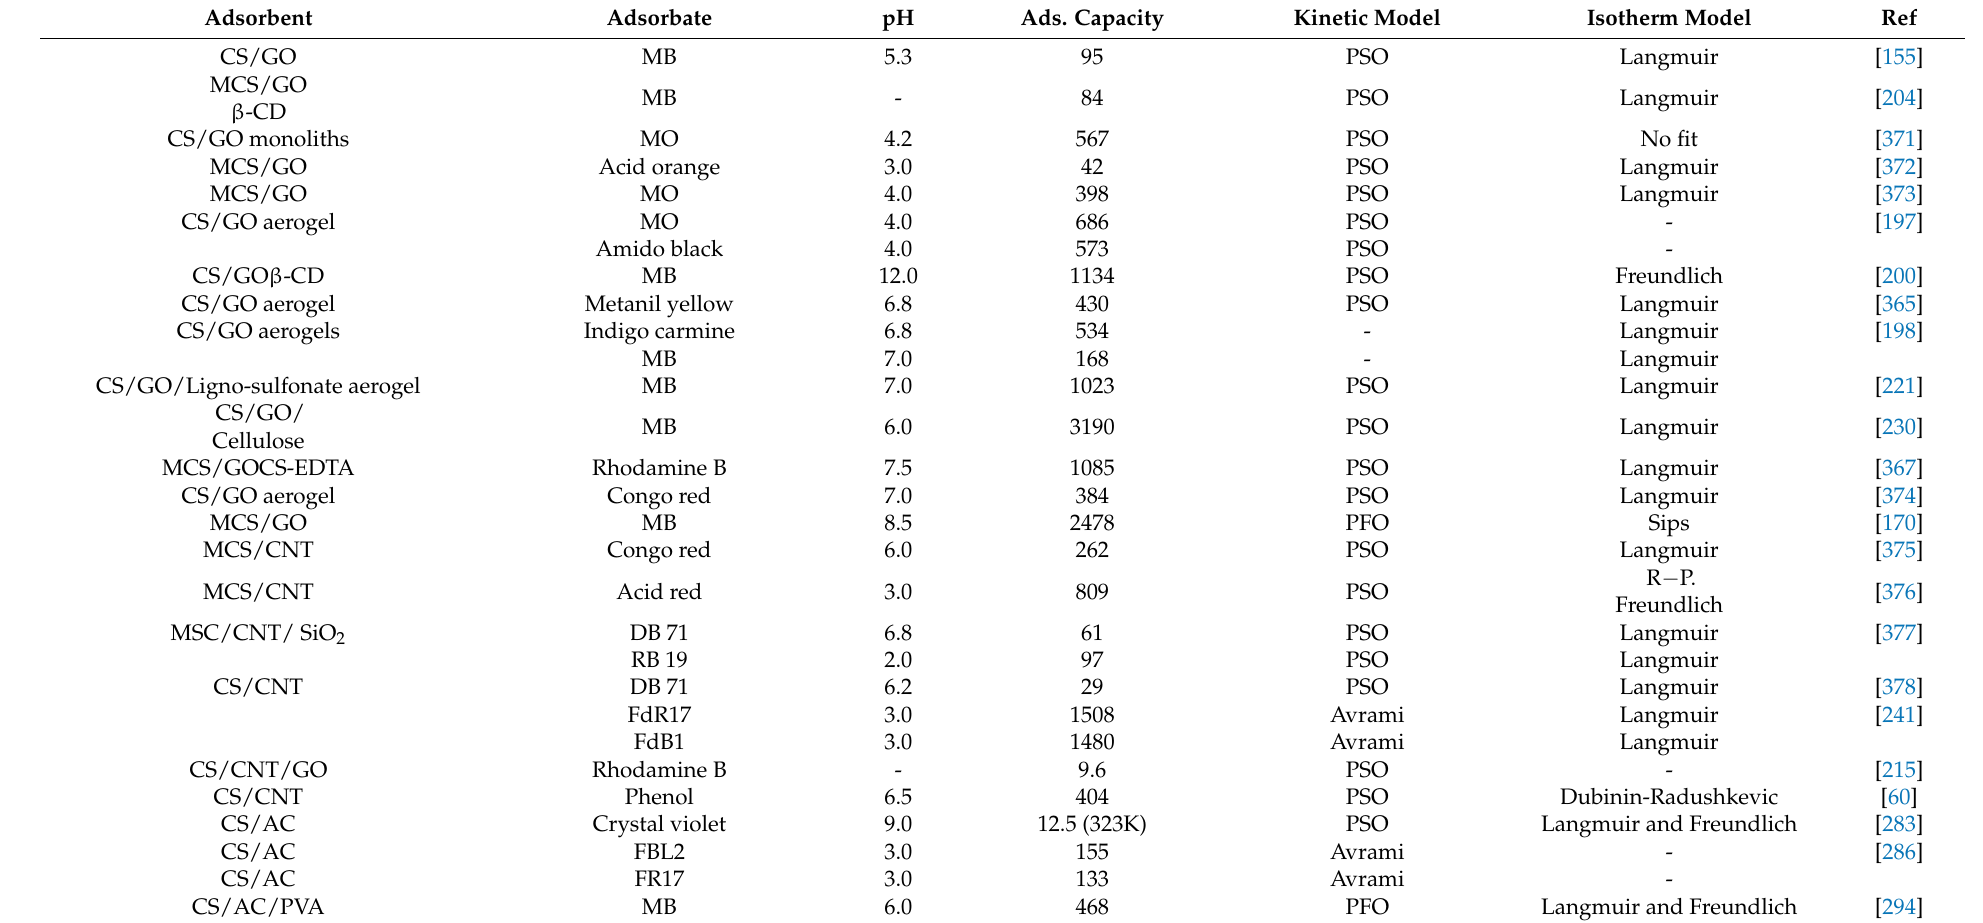
Table 8. Adsorption performance of chitosan composites in the removal pharmaceuticals, organics and drug molecules from